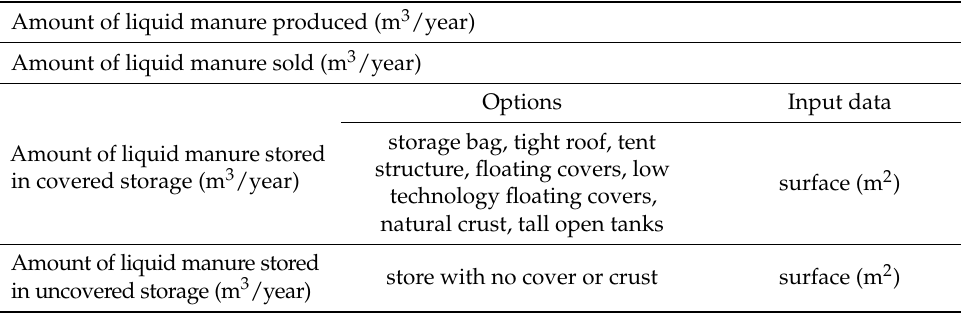
Table 5. The input data requirements of liquid manure